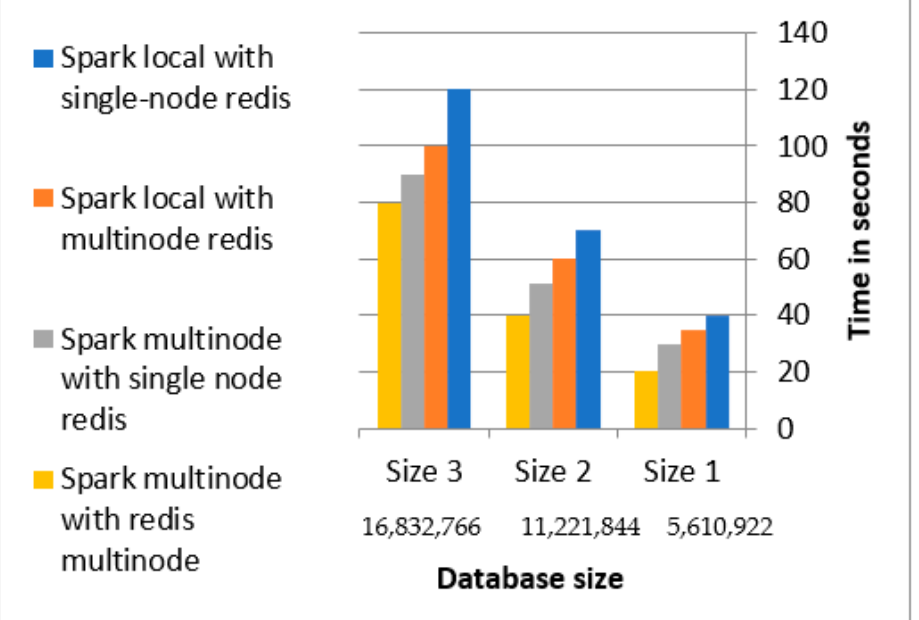
Figure 13. Elapsed time for executing query on Redis using the proposed layer.